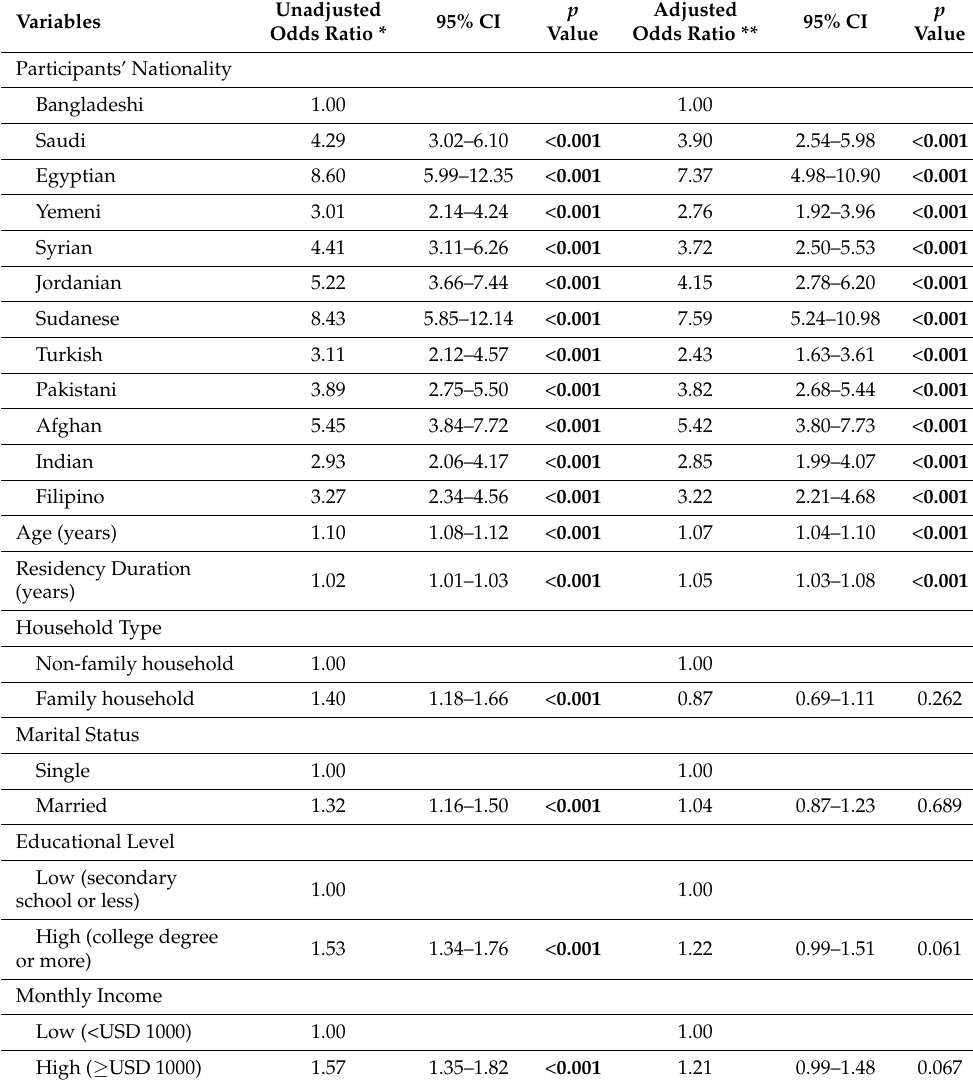
Table 4. Risk of overweight and obesity among study participants for sociodemographic